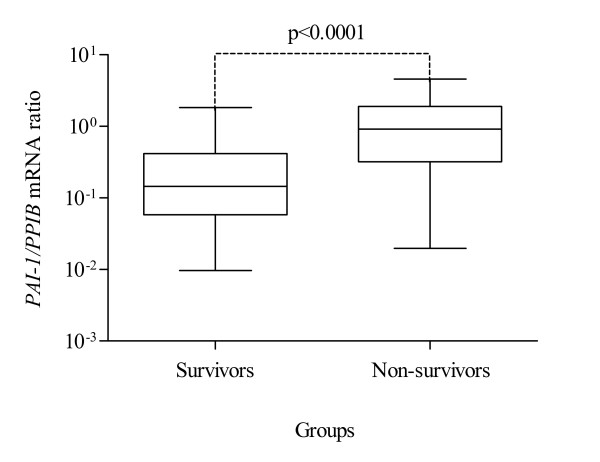
PAI-1 mRNA expression in relapsed and non-relapsed breast cancer patients as measured by quantitative RT-PCR. Differential PAI-1 gene expression between survivors (n = 65) and non-survivors (n = 22) with BCS as end-point (Mann-Whitney test; p < 0.0001).